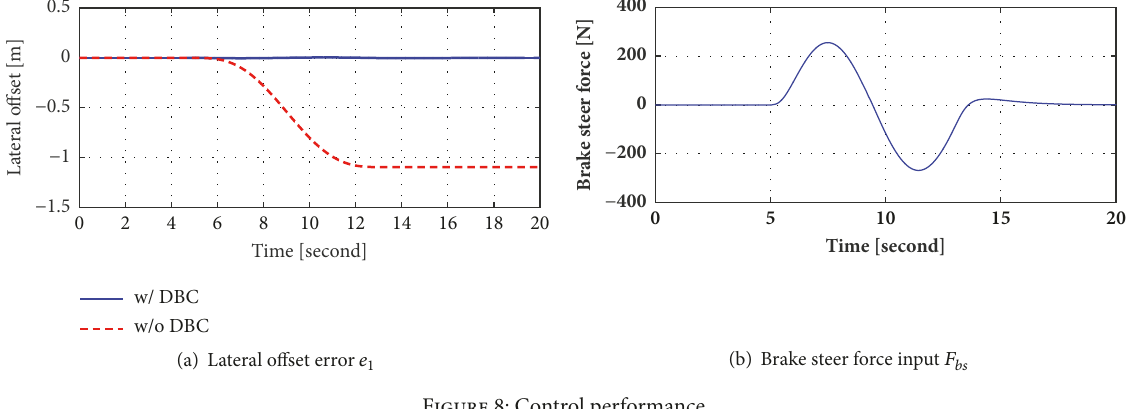
Figure 8: Control performance.